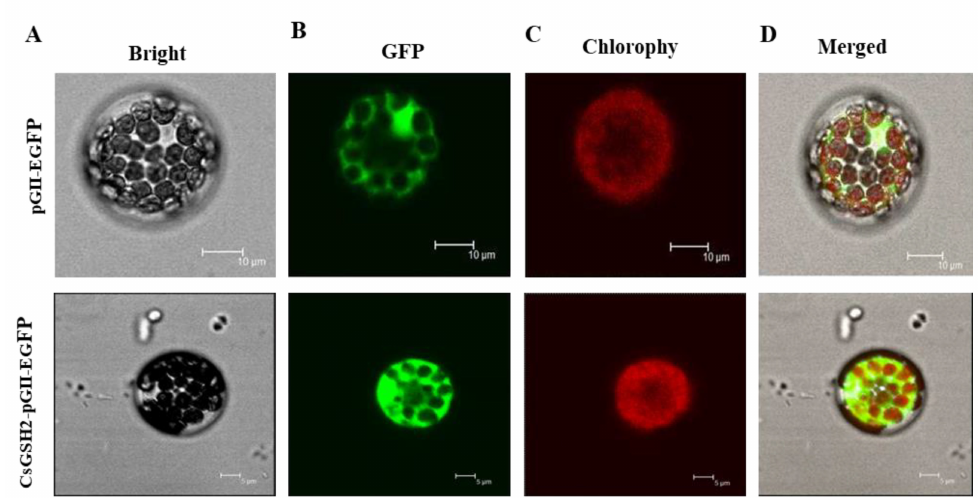
Figure 3. Subcellular localization of the CsGSH2 protein in Arabidopsis thaliana protoplasts. Green fluorescence indicates the localization of the fusion protein. ( A ) Bright-field illumination. ( B ) GFP fluorescence. ( C ) Chlorophyll fluorescence. ( D ) The overlay of GFP and chlorophyll fluorescence. Bar = 10 µ